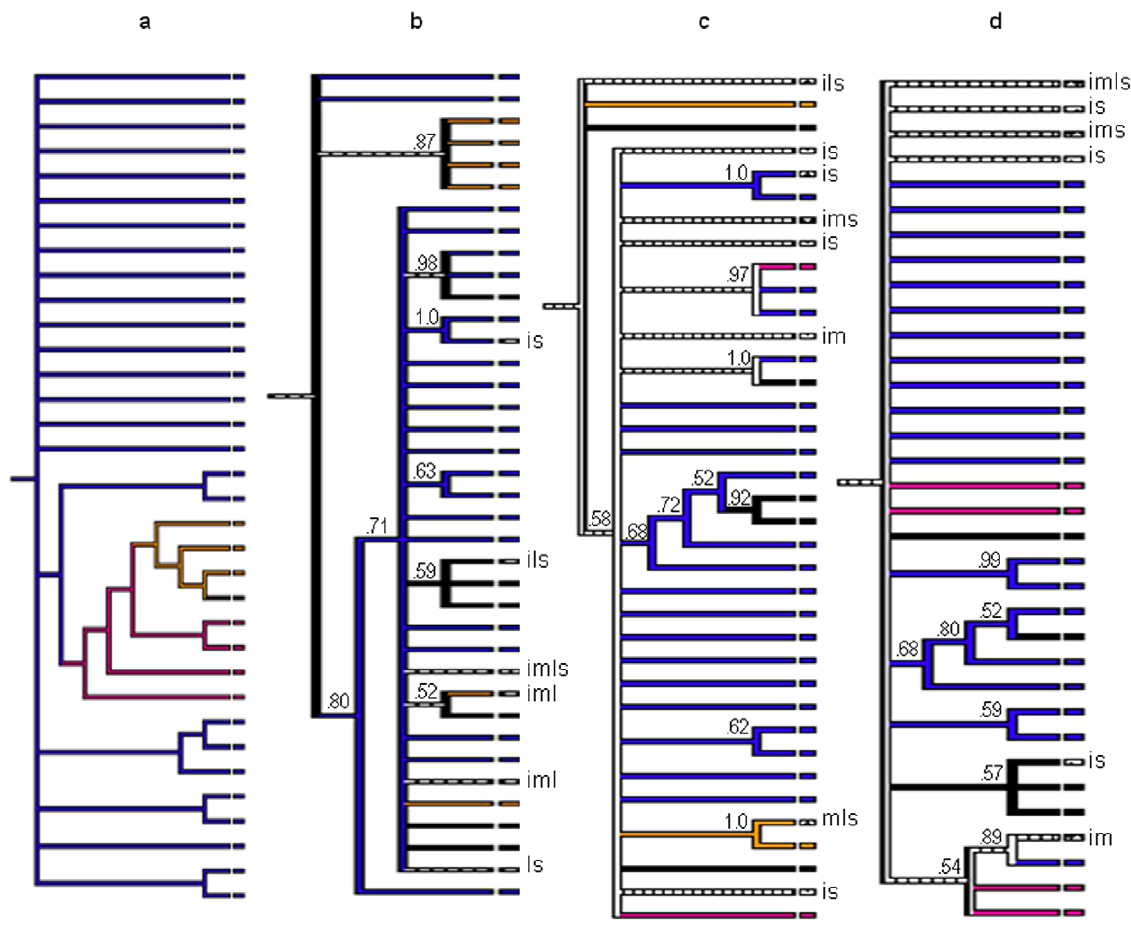
Figure 5. Bayesian trees with the most parsimonious reconstruction of tissue character states for three mosquitoes. Blue=input (i), pink=midgut (m), gold=legs (l), black=salivary secretions (s), dotted=multiple tissues, with specific tissues indicated by abbreviations. Hatched branches indicate equivocal reconstruction of character states. Numbers above nodes are the posterior probabilities inferred for each clade. A) Hypothetical tree with predicted outcome assuming the presence of genetic bottlenecks. The most parsimonious reconstruction of ordered character steps for each tree for three representative mosquitoes is as follows, B) 7 dpi mosquito 2 (22 steps, p , 0.0001), C) 14 dpi mosquito 1 (30 steps, p , 0.0001), D) 21 dpi mosquito 3 (23 steps,